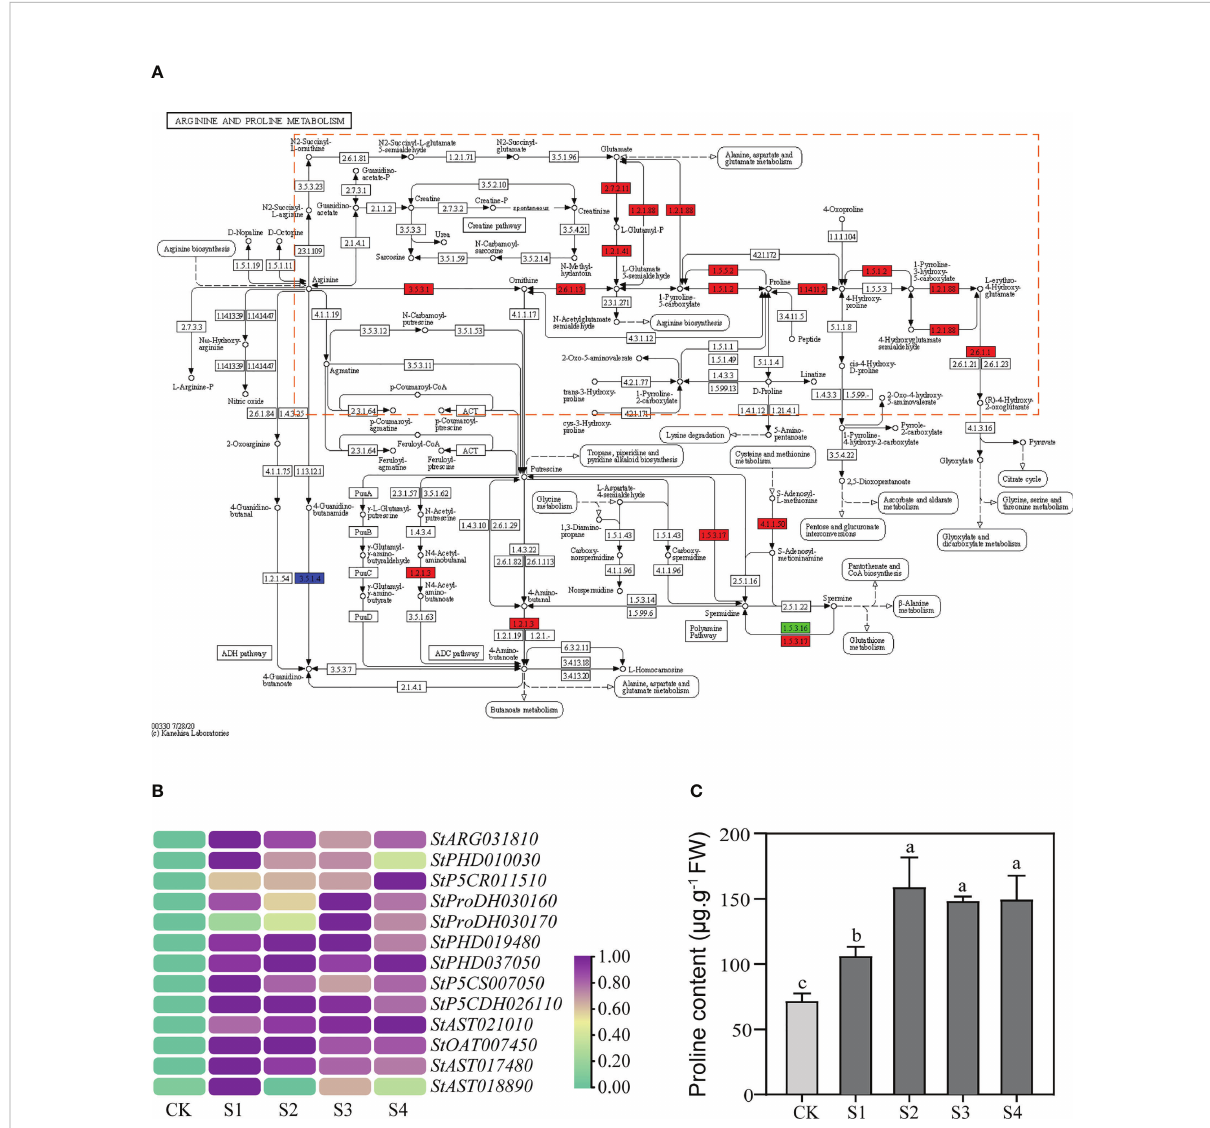
FIGURE 3 Expression levels of the structural DEGs in the proline metabolic pathway and the proline contents in the DM plantlets under salt stress. (A) Differential expression of the structural DEGs in KEGG enrichment analysis. The green rectangle represents the DEGs down-regulated; the red rectangle represents the DEGs up-regulated; the blue rectangle represents both up-regulated and down-regulated DEGs. The proline metabolic pathway is highlighted by orange dotted frame. (B) Heat map of the structural DEGs in the proline metabolic pathway. (C) Changes of the proline contents in aboveground parts of DM text-tube plantlets under the 200-mM NaCl treatments. Data presented as mean ± standard error from three biological replicates were tested by one-way analysis of variance (ANOVA). Different letters represent statistically signi fi cant differences ( a